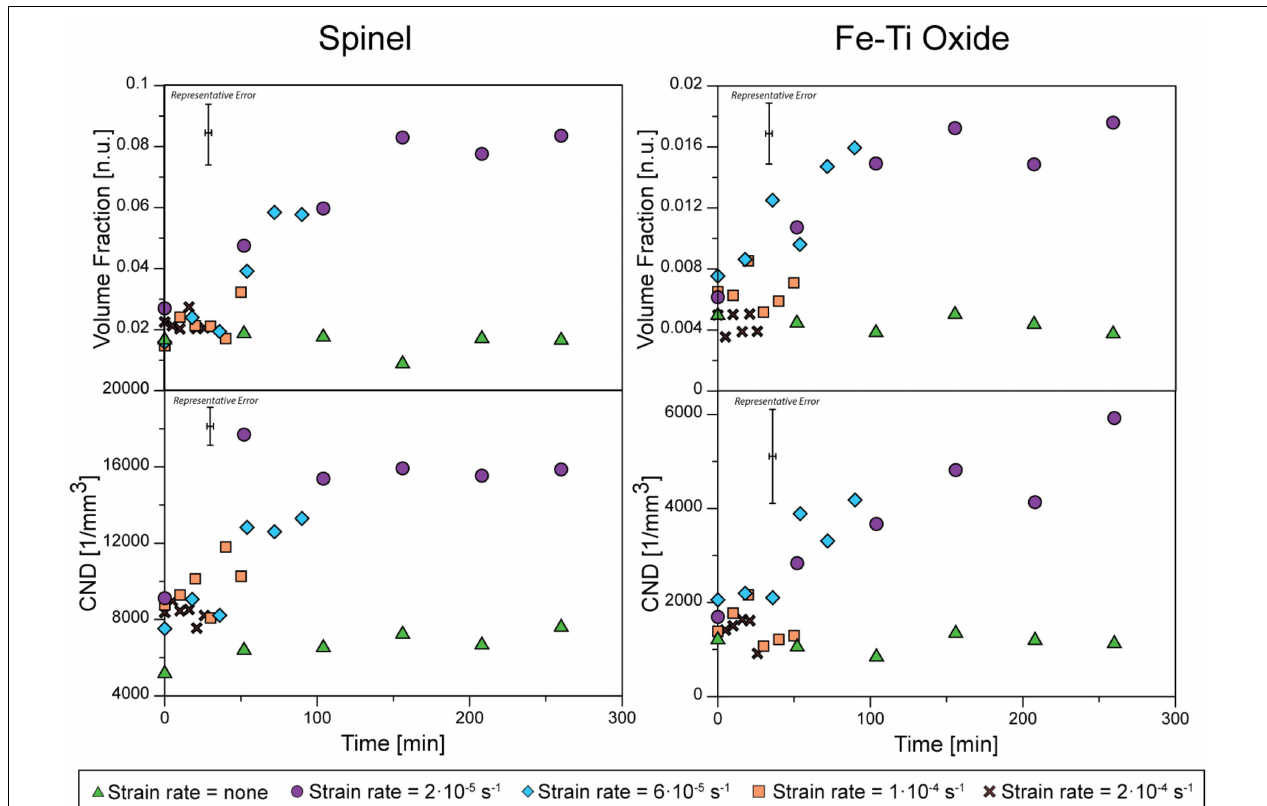
FIGURE 3 | Microstructure evolution of the spinel (on the left ) and Fe-Ti oxide (on the right ) determined using the XRT images. The volume fraction and the crystal number density (CND) are plotted for each strain rate applied during the